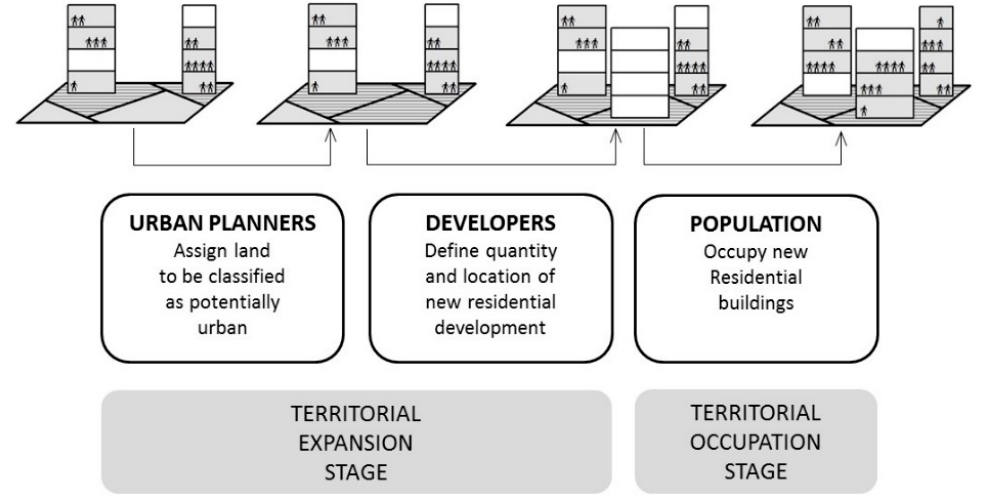
Figure 2. Integrated decision model to simulate urban growth.